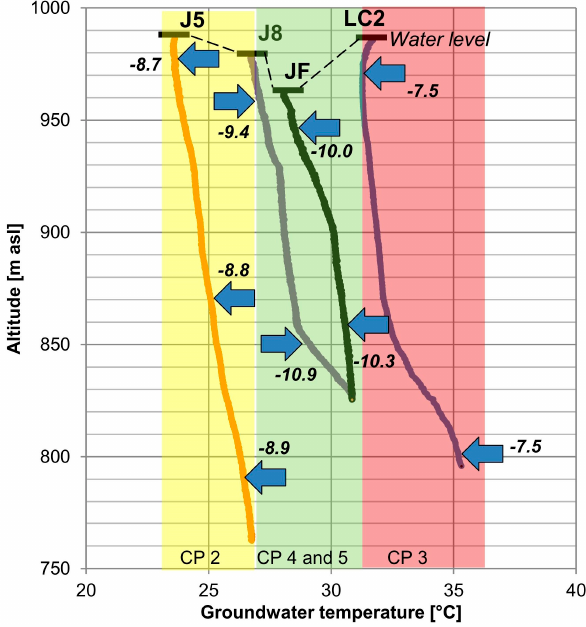
Figure 7. Temperature logs of wells J5, J8, JF and LC2 and depth of depth-specific stable isotope samples (blue arrows mark sample depth of depth-specific samples, italic numbers indicate measured δ 18 O values). Table 2. Depth-specific samples taken for this study (locations displayed in Figure 2B).